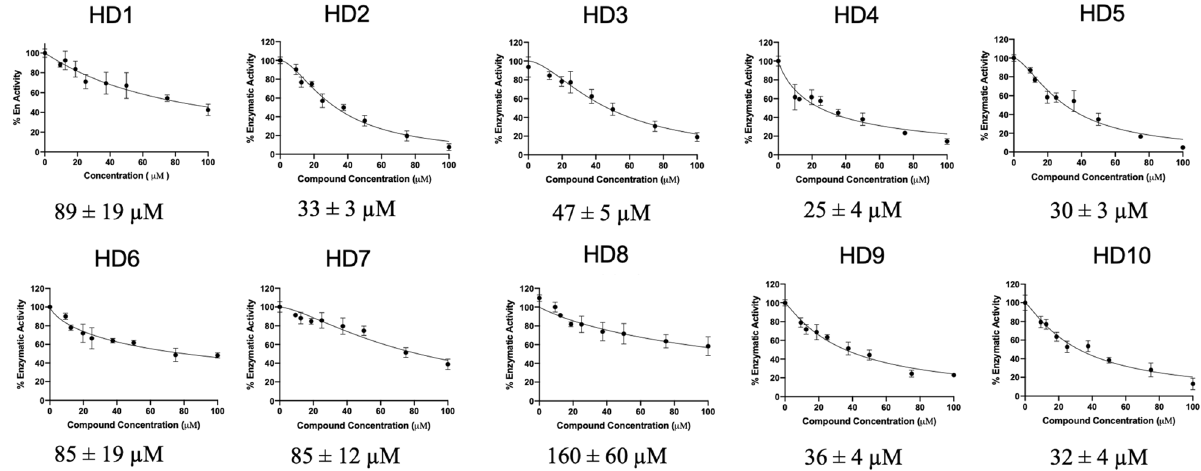
Figure 3. EC 50 curves for histidine/histamine derivatives. The figure represents generated dose–response curves using a coupled fluorescence polarization assay. The EC 50 values for the compounds are located below each plot and were calculated to the 95% confidence